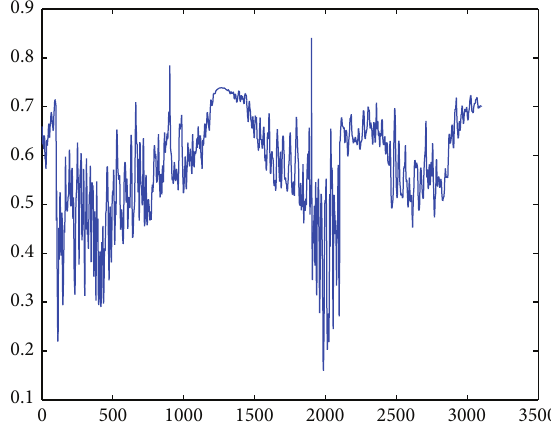
Figure 2: The normalization of network traffic time